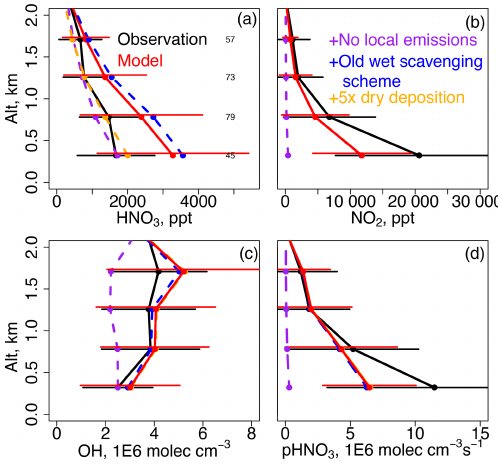
Figure 6. Mean vertical profiles of (a) HNO 3 , (b) NO 2 , (c) OH, and (d) production of HNO 3 (pHNO 3 ) for the same domain as Fig. 3 but accounting for the availability of OH, NO 2 , and HNO 3 observa- tions. The horizontal bars show the observed and modeled standard deviations. The numbers of points in each altitude bin are shown in panel (a) . Model sensitivity simulations that are not significantly different than the base model run are plotted underneath the base model